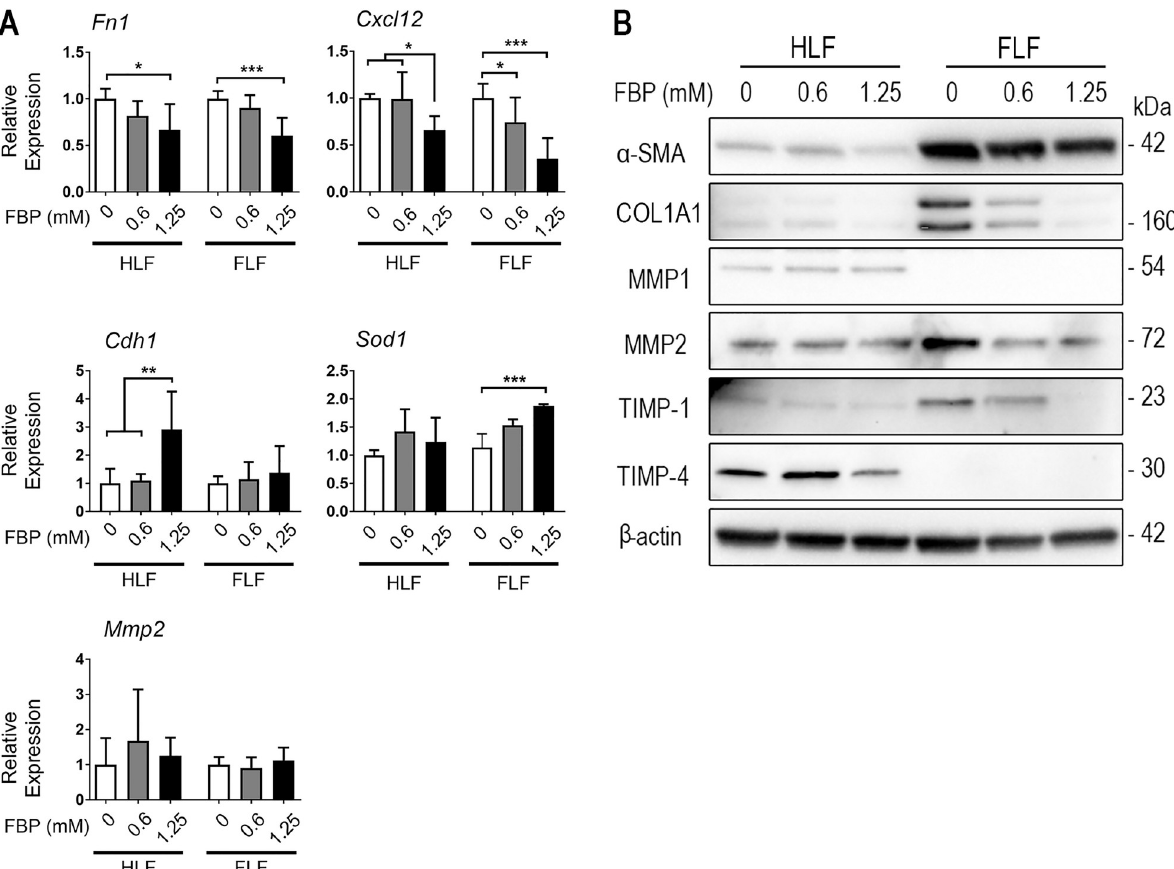
Fig 6. Fructose-1,6-bisphosphate regulates expression of ECM and ECM-degrading proteins in vitro . (A) qRT-PCR analysis for the levels of Fn1, Cxcl12, Cdh1, superoxide dismutase 1 (Sod1), and metalloproteinase 2 (Mmp2) mRNAs. Relative expression is presented based on the expression level of control as 1. One-way ANOVA followed by Tukey’s multiple comparison test was used. Values are expressed as mean ± SD; n = 4–6/group; � p < 0.05; �� p < 0.01; ��� p < 0.001. (B) Protein expression of α -SMA, COL1A1, MMP1, MMP2, TIMP-1, and TIMP-4 in HLF and FLF treated with FBP for 3